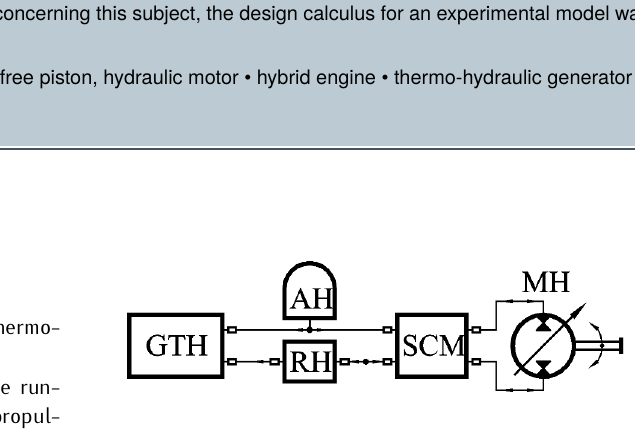
Figure 1. The scheme of the thermal-hydraulic propulsion system